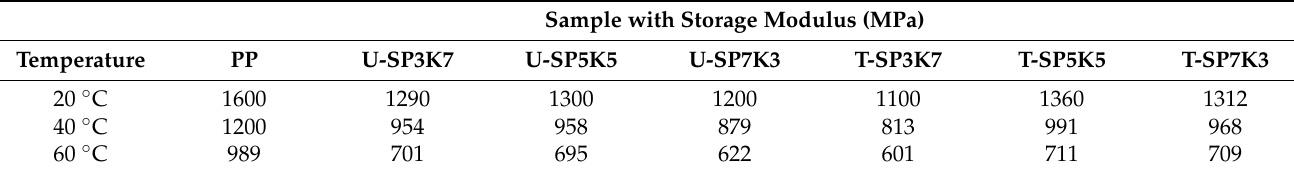
Table 4. Hybrid composite sample (SP/K/PP) with storage modulus